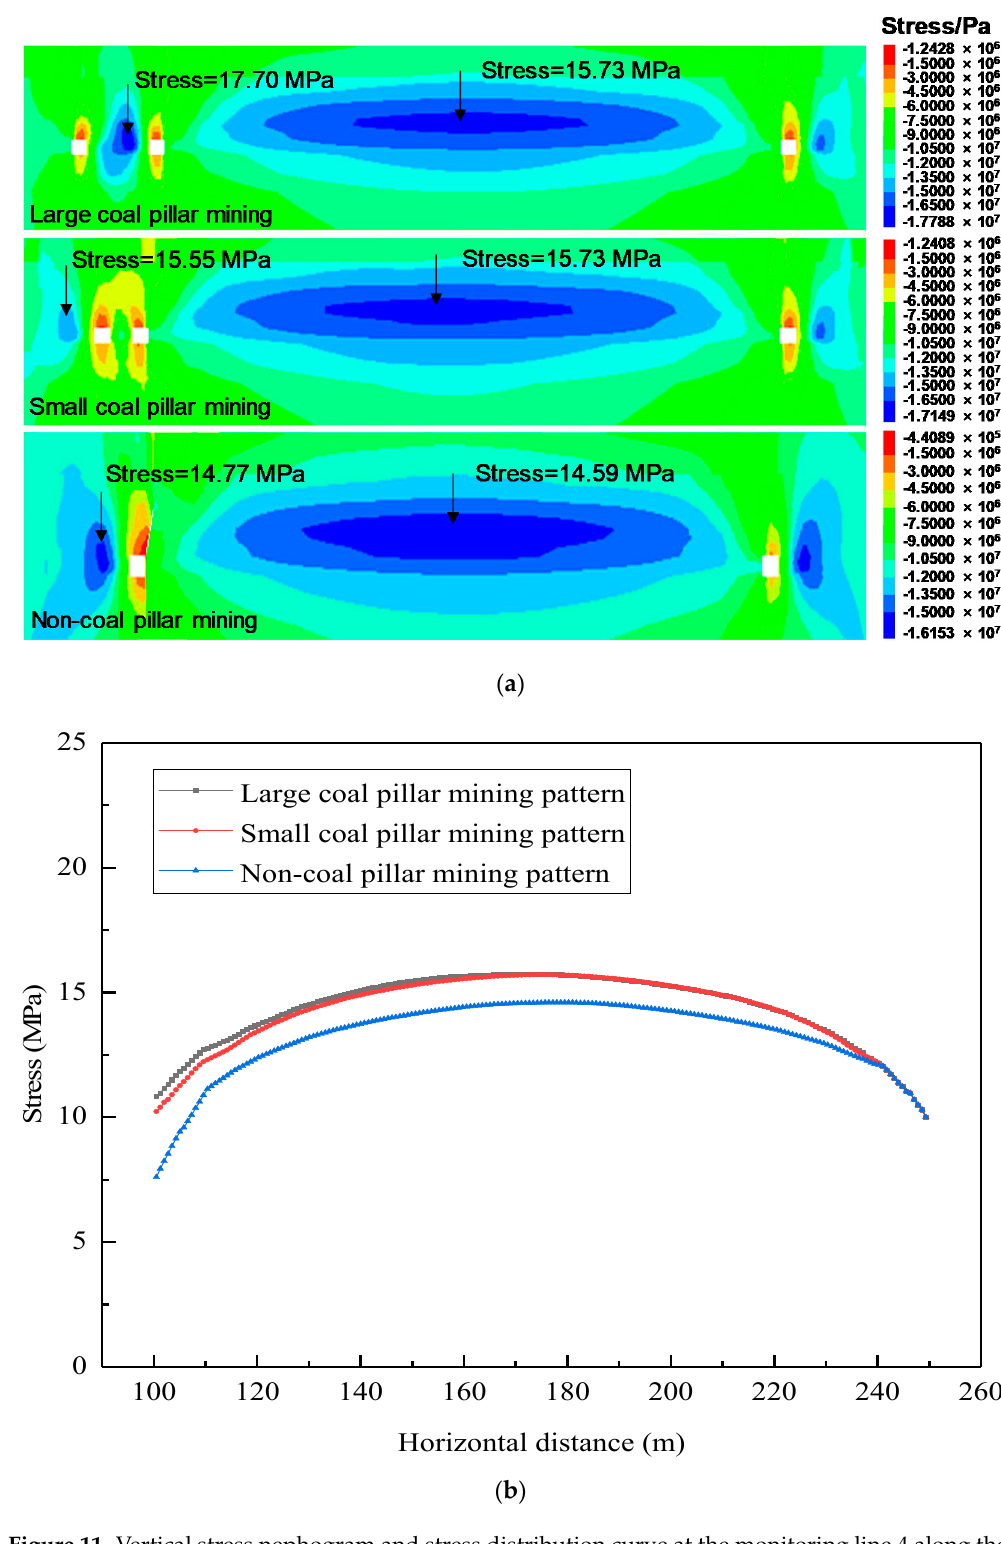
Figure 11. Vertical stress nephogram and stress distribution curve at the monitoring line 4 along the inclination of the working face. ( a ) Vertical stress nephogram; ( b ) Vertical stress distribution curve. Through the above analysis, the key parameters of the stress distribution characteristics along the inclination of the working face were summarized, and a matrix-type chart with resulting values and illustrations was made (as shown in Table 4).